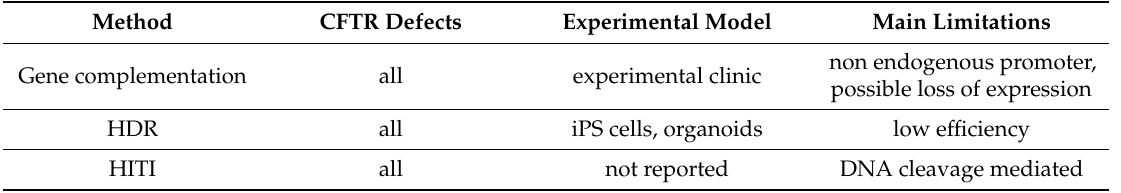
Table 1. Genome editing techniques applied in CF models and main reported limitations.